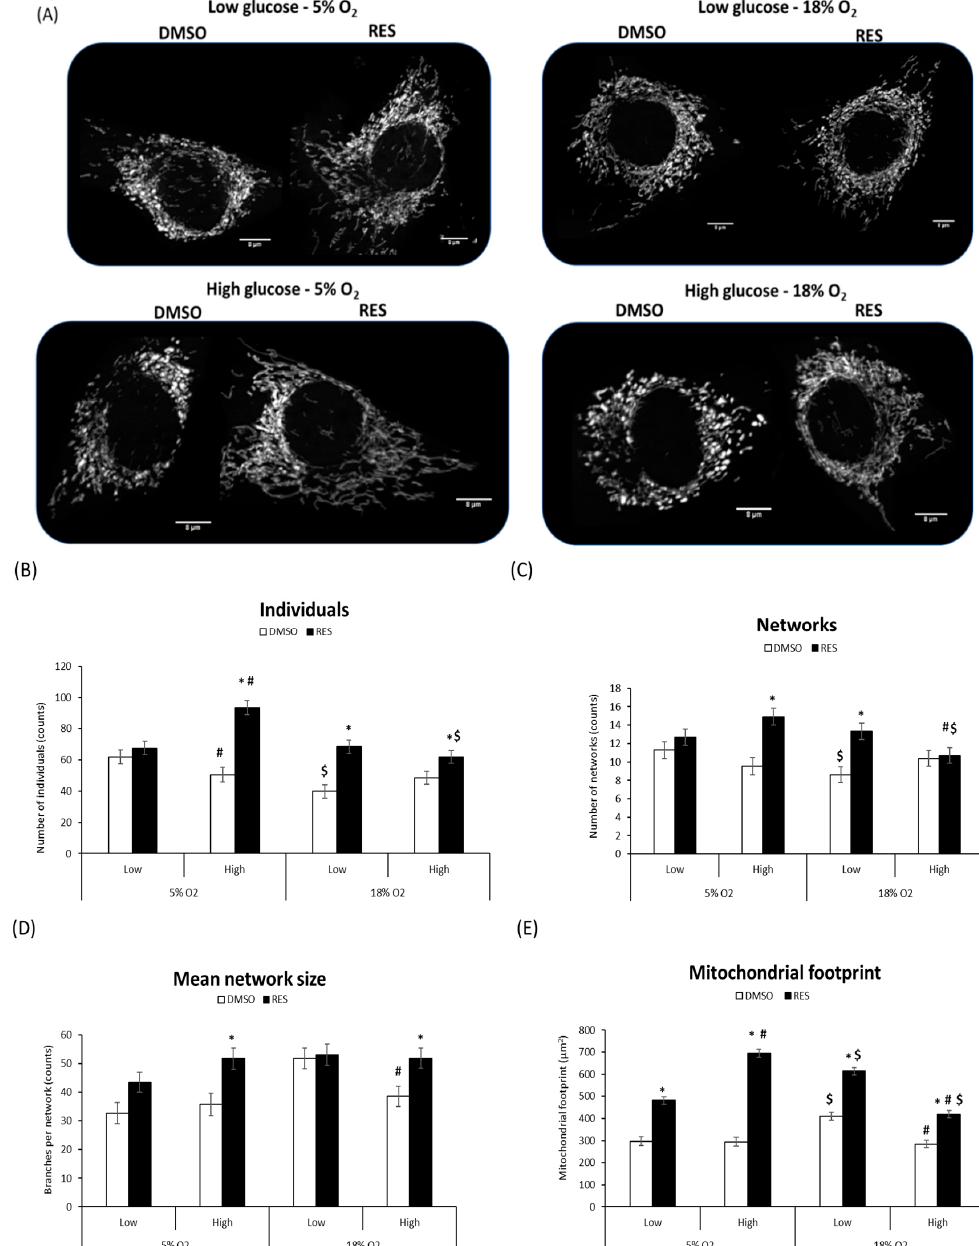
Figure 3. RES effects on mitochondrial network parameters are subtly affected by media glucose and oxygen levels in C2C12 cells. ( A ) Representative images of mitochondrial networks in C2C12 cells. There was a main effect of resveratrol on the number of individuals ( B ), networks ( C ), mean network size (branches per network) ( D ) and mitochondrial footprint ( E ). Overall, treatment with RES increased all these mitochondrial network parameters. An interaction between oxygen*glucose*treatment was also observed between individuals ( B ), number of networks ( C ) and mitochondrial footprint ( E ). A glucose and oxygen interaction was observed for mean network size (branches per network) ( D ). Total magnification in all experiments was 630×. Cells were treated for 48 h with 10 µ M RES (filled bars) or an equal volume of vehicle control (DMSO; open bars). Data shown are means ± SEM of at least 3 independent experiments. For each condition at least 30 randomly selected individual cells were analyzed using MiNA. ‘*’ represents differences between RES-treated and DMSO-treated cells, p < 0.05. ‘#’ represents differences between low and high glucose levels, p < 0.05. ‘$’ represents differences between low and high oxygen levels.